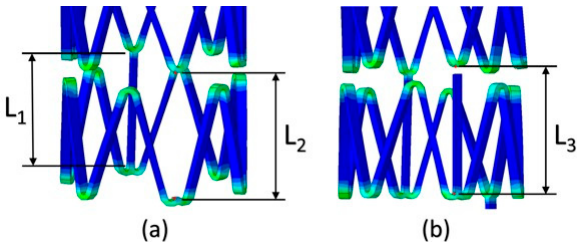
Figure 9. The comparisons of the single-connector stent antennas when the connector was ( a ) completely removed, and ( b ) partially removed.